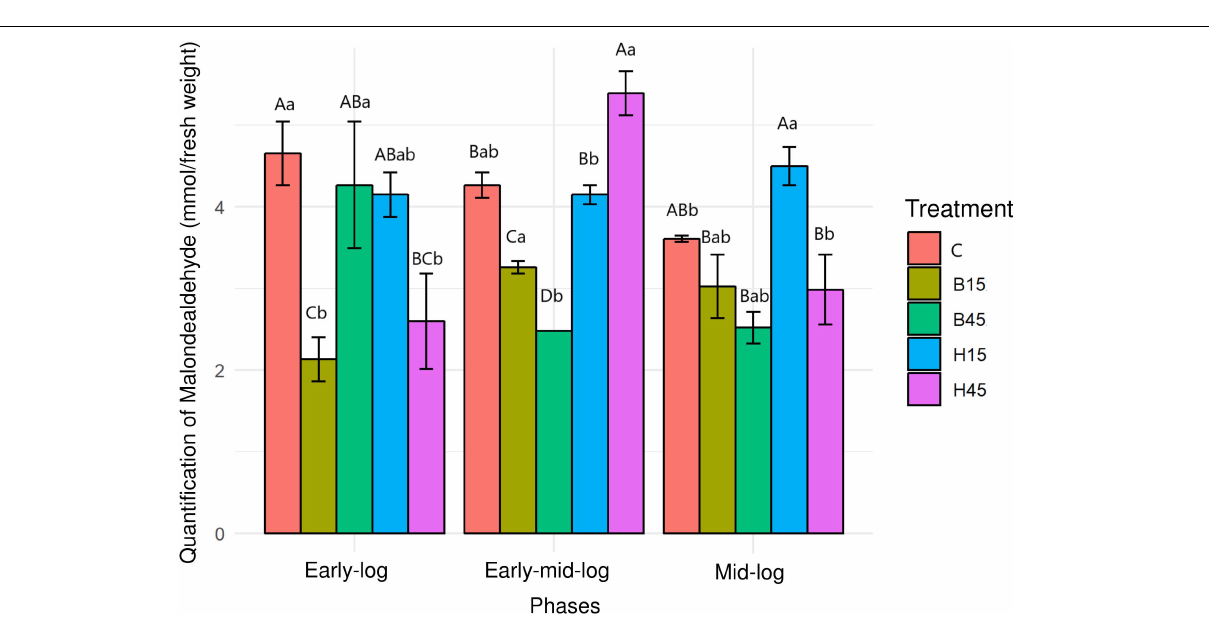
Enzymatic Activity of GST Quantitative analysis of GST for Pseudomonas sp. CMA 6.9 is shown in Figure 8 .